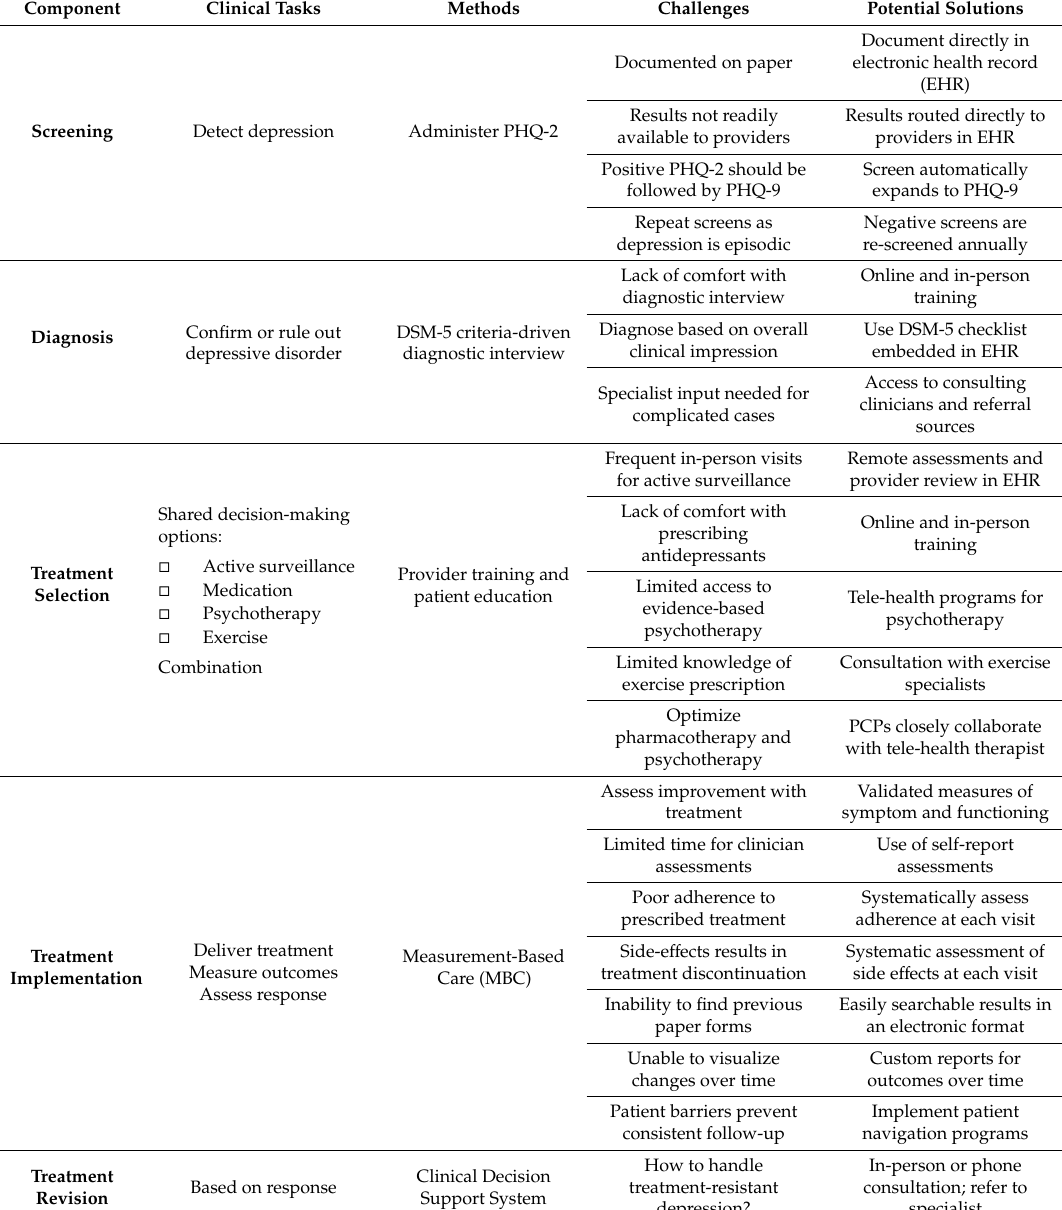
Table 1. The Primary Care First (PCP)-First Approach to the Treatment of